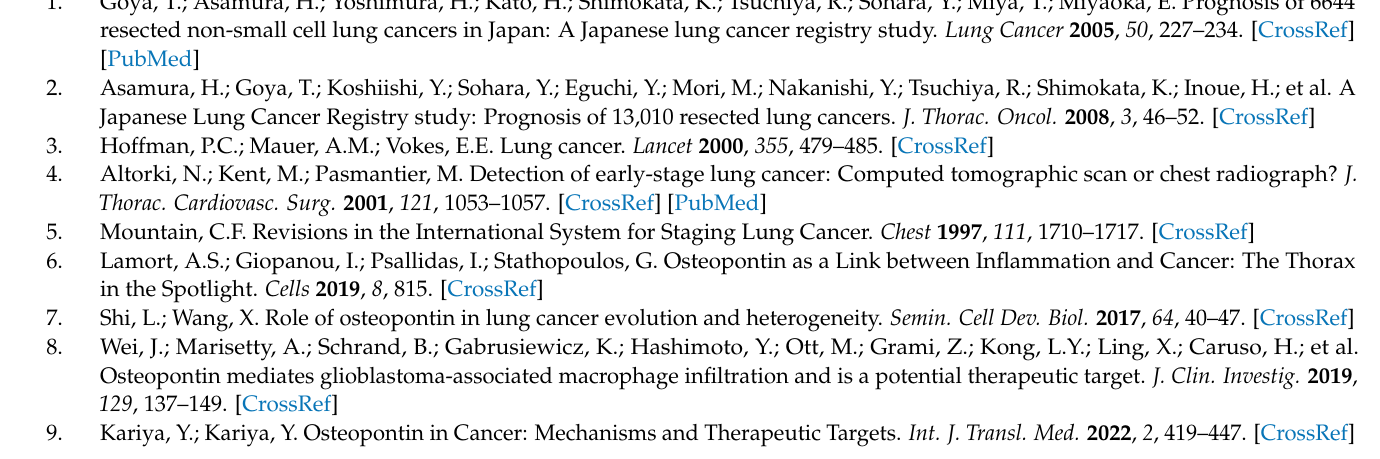
Table S4: TAM-SPP1 expression and PD-L1 expression of cancer cells or TAM in lung adenocarcinoma. File S1: The original Western Blot figures of the Figures 4, 6 and